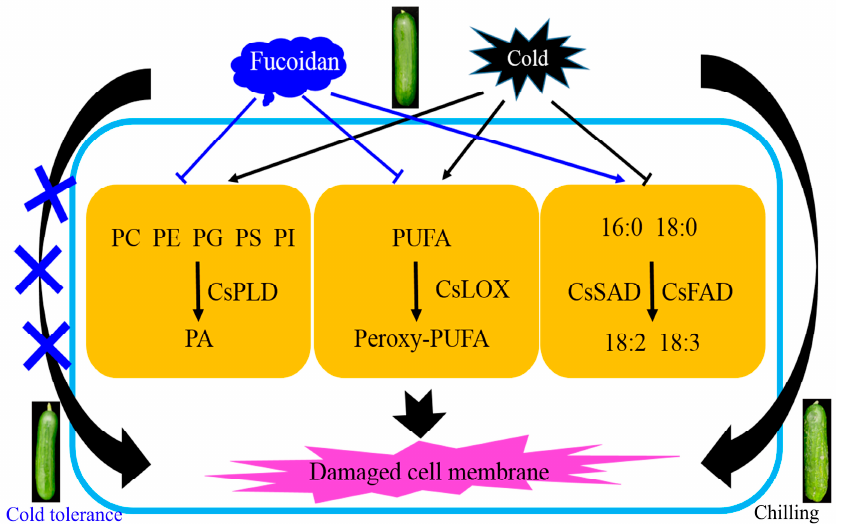
Figure 6. Amelioration of chilling injury in cold-stored cucumber fruit by potential mechanism of fucoidan acting on membrane lipid metabolism. PC, phosphatidylcholine; PE, phosphatidylethan- olamine; PG, phosphatidylglycerol; PS, phosphatidylserine; PI, phosphatidylinositol; PA, phospha- tidic acid; PUFA, polyunsaturated fatty acid; 16:0, palmitic acid; 18:0, stearic acid; 18:2, linoleic acid; 18:3, linolenic